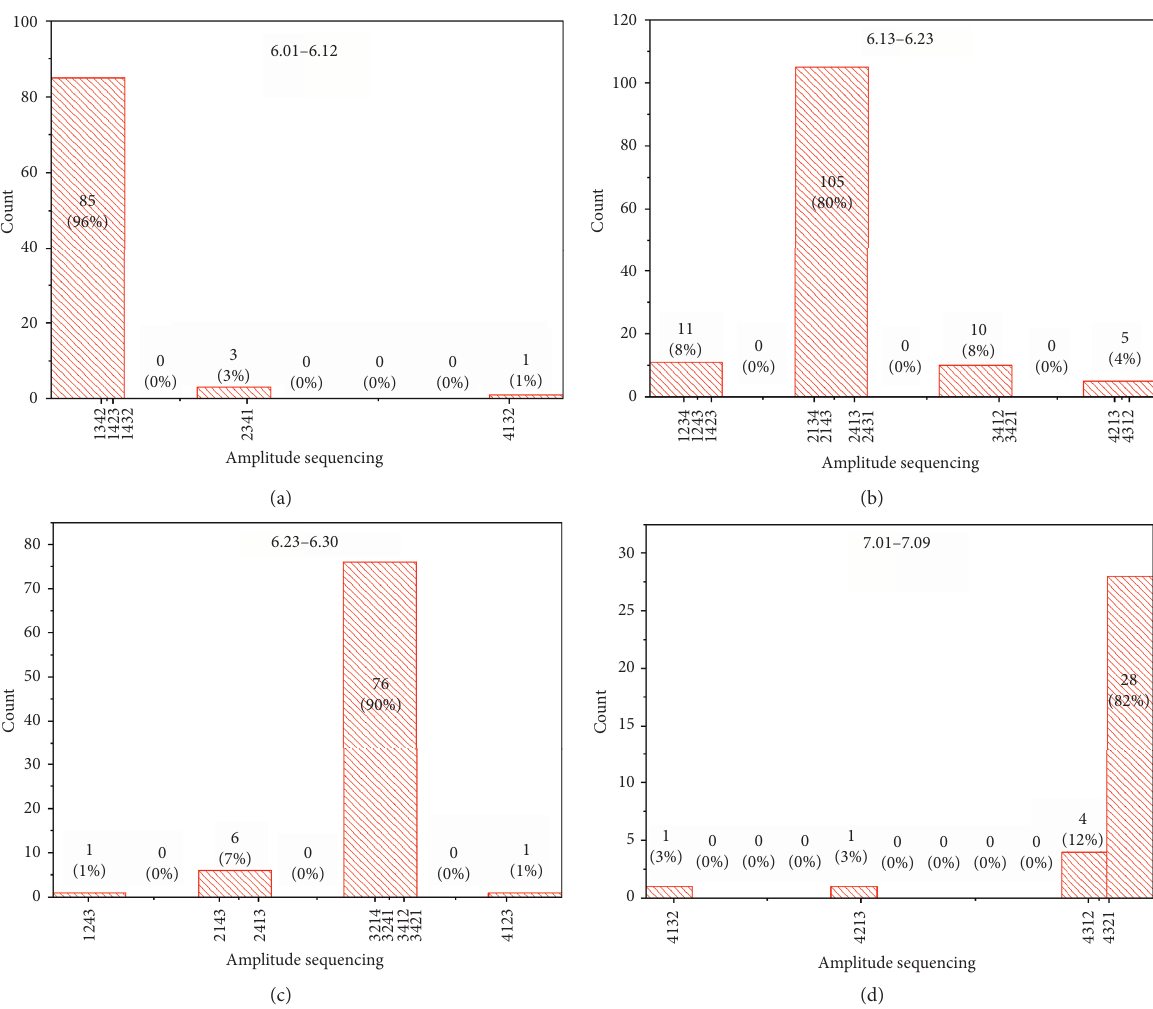
Figure 9: Statistical results of the proportion of amplitude sequencing in different